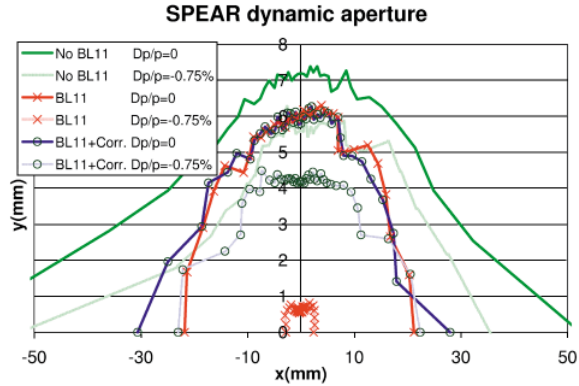
FIG. 8. (Color) Dynamic aperture tracking with BETA . (Corr: with nonlinear corrector magnets.)